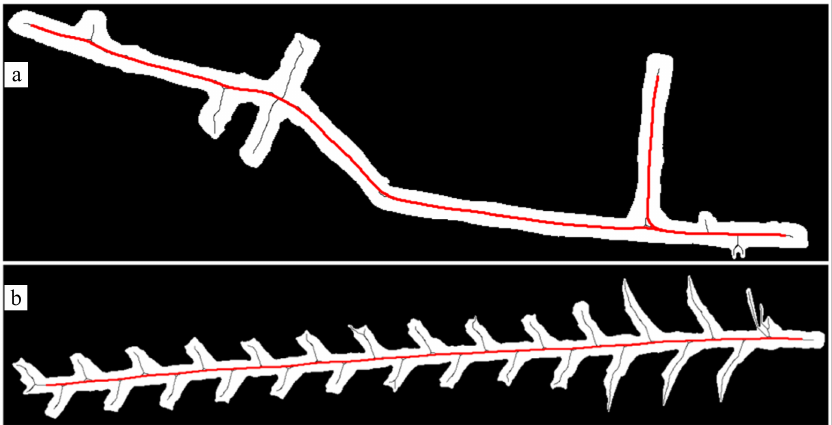
Figure 23. Global path planning for the proposed method; ( a , b ) denote the extraction of the laneway centerline of the maps corresponding to dataset 1 and dataset 2, respectively. Note: The black line in the map is the extracted map skeleton of the proposed method, and the red line in the maps is the smoothed centerline of the main